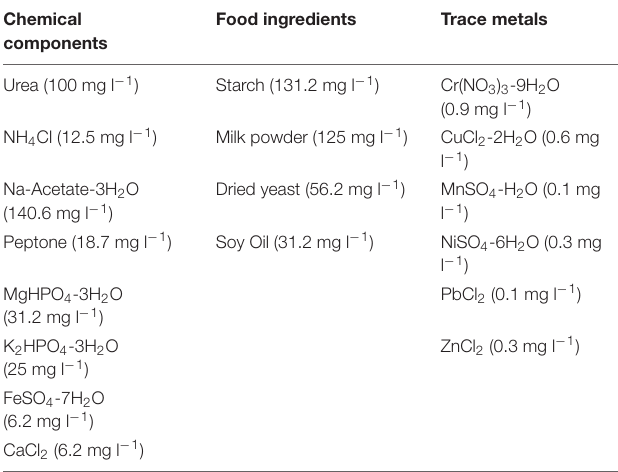
Food ingredients